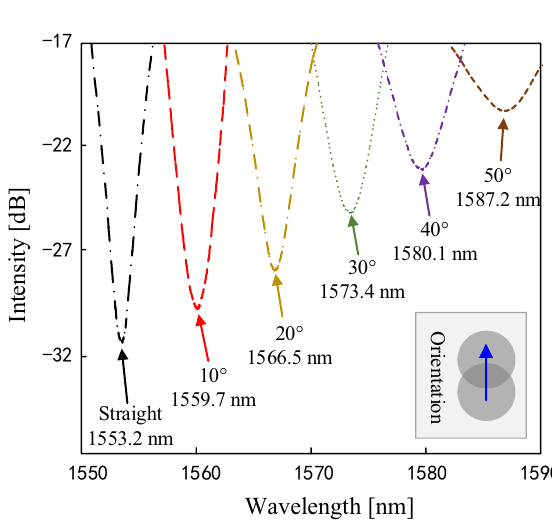
Figure 5. Some interference valleys of the inclinometer with the angle from 0° and